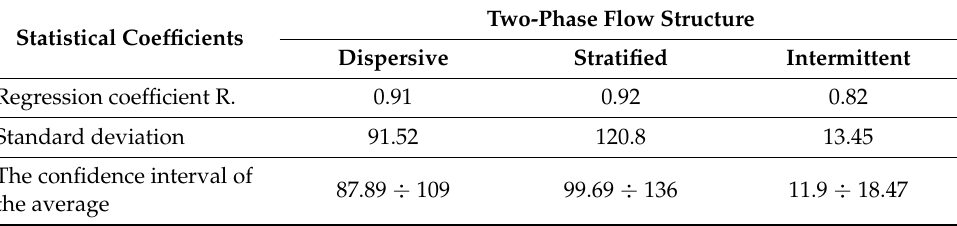
Table 6. Statistical coefficients determined for the heat transfer model described by Equation (3).